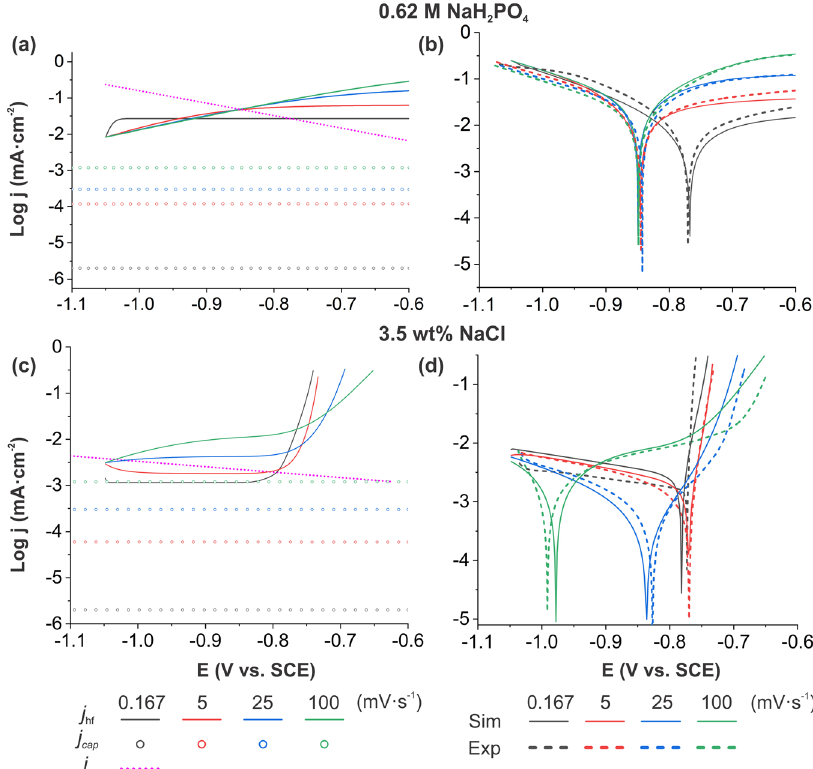
Fig. 6 Simulated PDP with the addition of the high fi eld anodic current, j hf . a Simulated j hf , j cap , and j c for PDP in 0.62 M NaH 2 PO 4 . b Fitted curves for PDP in 0.62 M NaH 2 PO 4 . c Simulated j hf , j cap , and j c for PDP in 3.5 wt% NaCl. d Fitted curves for PDP in 3.5 wt%